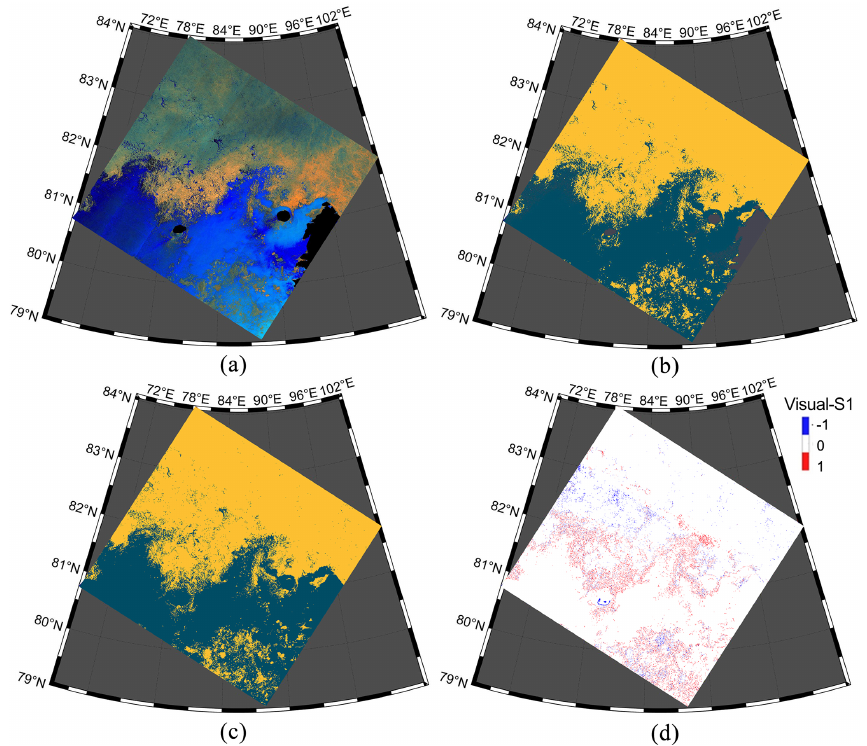
Figure 10. An example of S1-derived sea ice cover and its comparison with the visual interpretation result. (a) RGB false-color com- posite image. Panels (b) and (c) are S1-derived and visual interpretation of sea ice cover, with yellow indicating sea ice, cyan indicating open water, and gray indicating land. (d) Differences in sea ice cover between (b) and (c) (visual interpretation–S1 derive). (Image ID: S1B_EW_GRDM_1SDH_20190801T022310_20190801T022410_017386_020B16_F790).